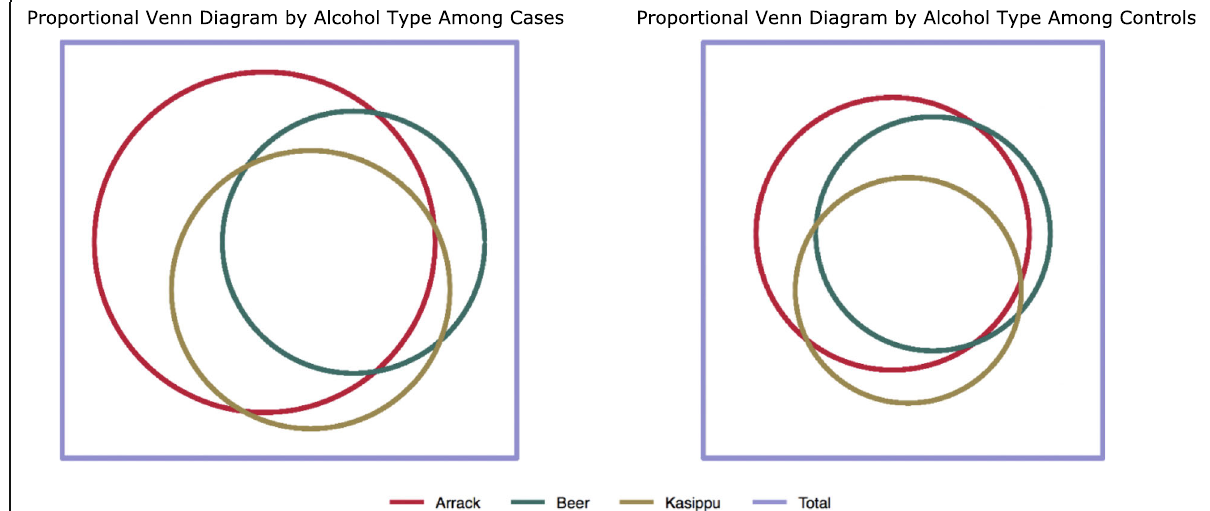
Fig. 2 Proportional Venn Diagrams Representing Reported Alcohol Type Consumed by Case-Control